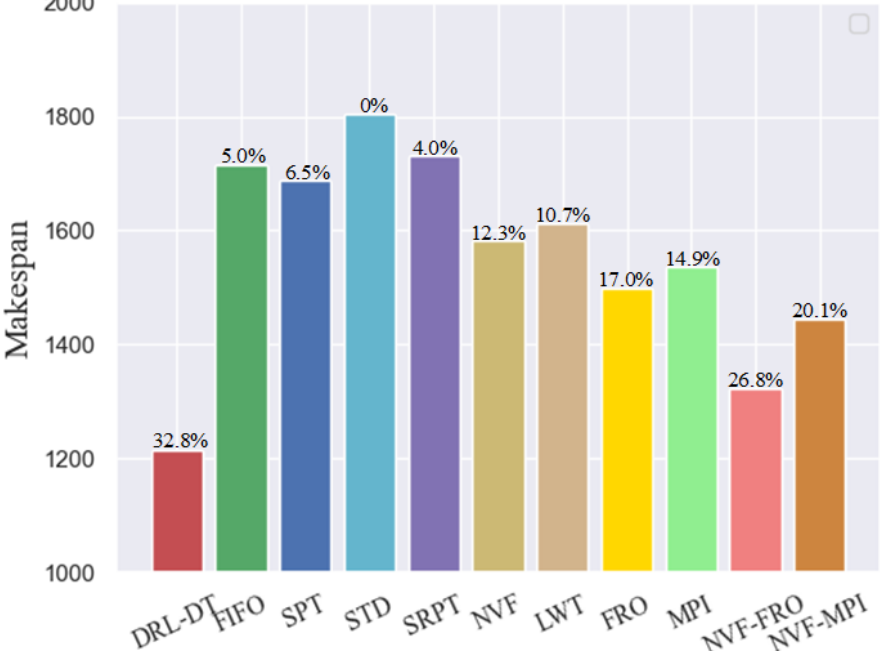
Figure 5. Comparison of the improvement of makespan depending on the method.